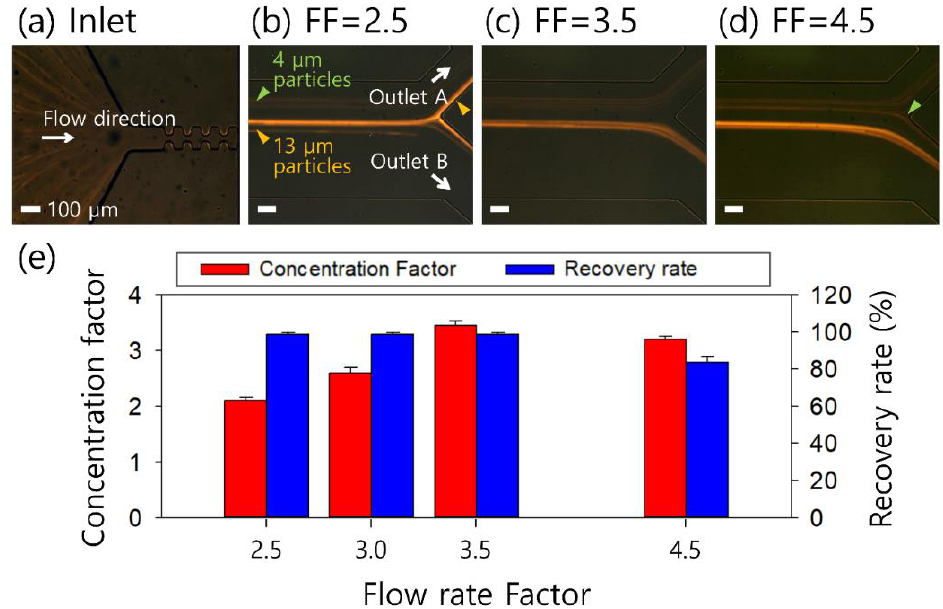
Figure 2. Viscoelastic separation of 4 and 13 μ m particles at the ( a ) inlet and outlet depends on the flow rate factors of ( b ) 2.5, ( c ) 3.5, and ( d ) 4.5 at the inlet flow rate of 800 μ L/min. Green and yellow triangles indicate 4 and 13 μ m particles, respectively. ( e ) Concentration ratio and recovery rate of 4 μ m particles at the center outlet (outlet A).